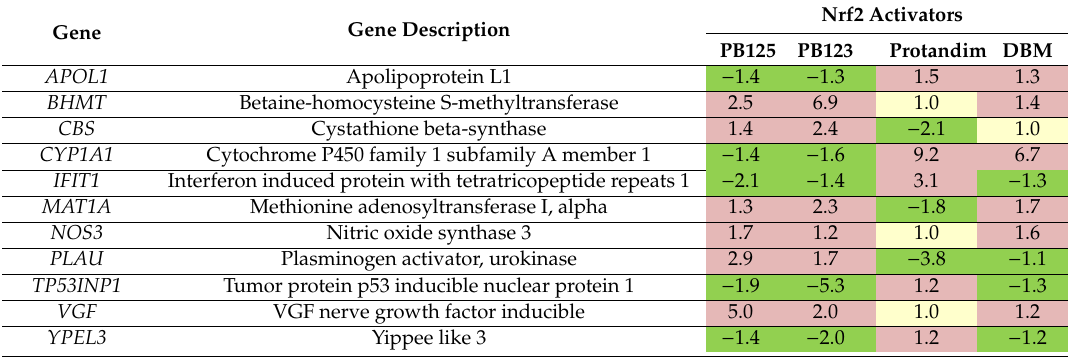
Table 4. Genes that are inconsistently regulated by four di ff erent Nrf2 activators. The numbers reflect fold-induction of the respective mRNA levels based on averages of 3 independent microarray or RNA-seq experiments for PB125 treatment (16 µ g / mL), and single microarray experiments for the comparison treatments (PB123, Protandim, and DBM). In no case was one of these eleven genes regulated in the same direction by all four Nrf2 activators (upregulation shaded in red; no e ff ect in yellow; downregulation shaded in